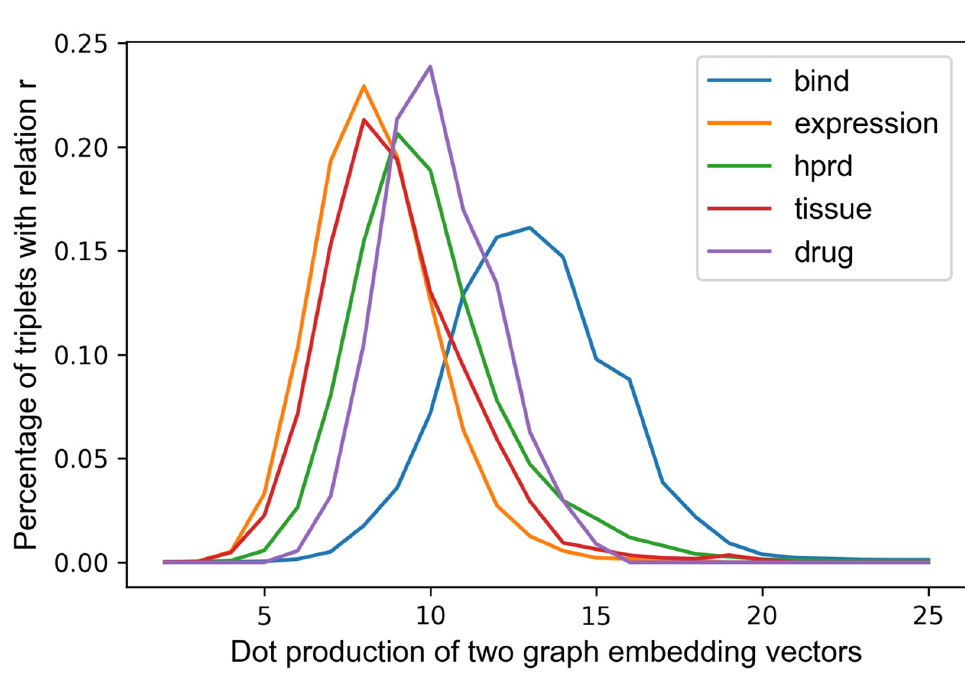
Fig 3. Correlation between graph embedding and